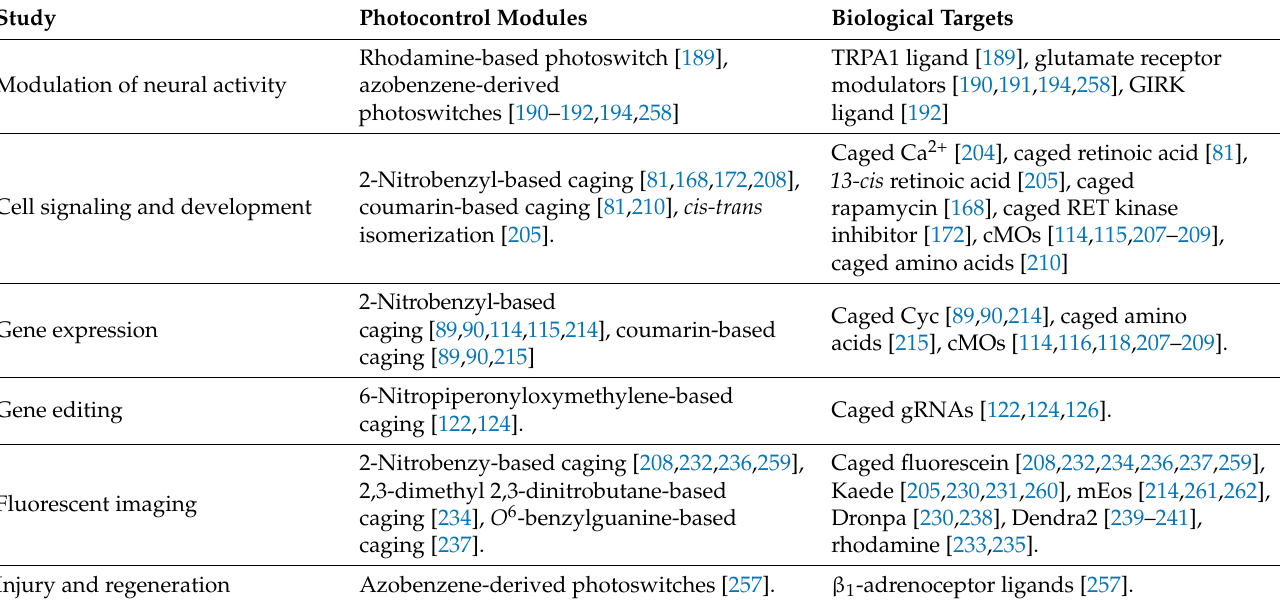
Table 2. Representative applications of opto-chemical tools in the